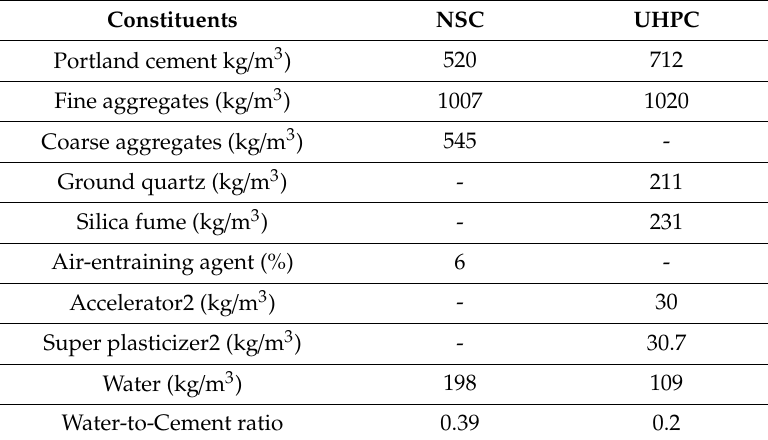
Table 1. Concrete mix